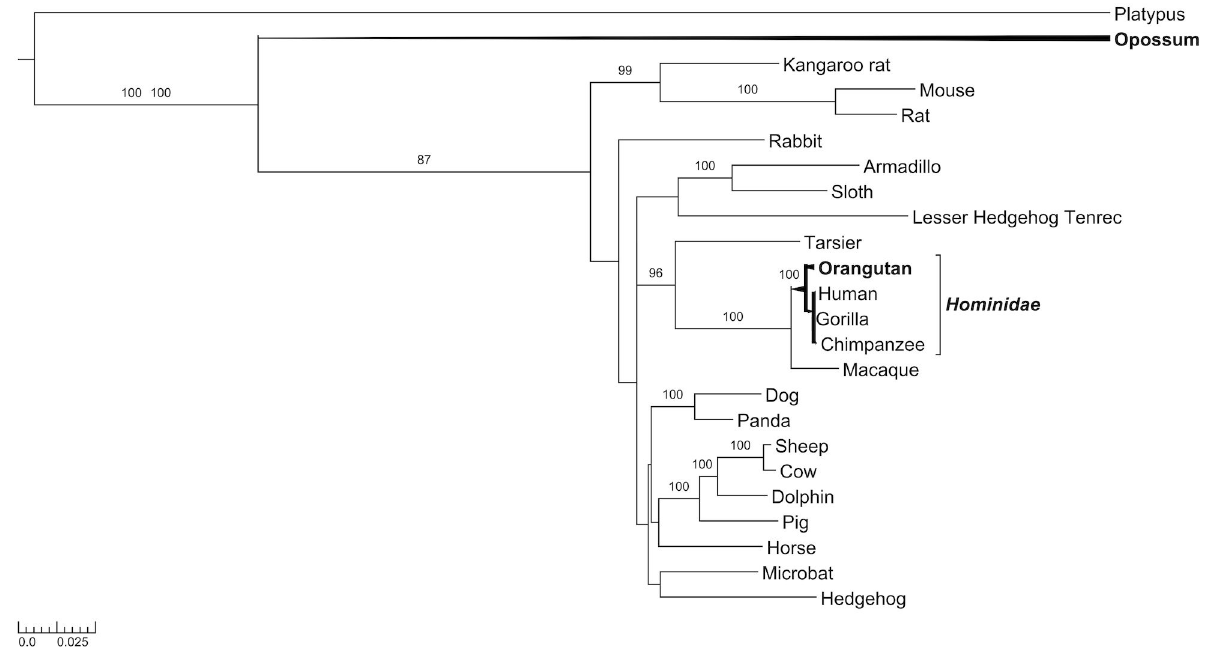
Figure 2. BMP15 positive selection pressure among mammals. Phylogenetic tree of BMP15 from 24 mammals species reconstructed using TreeBeST and rooted by minimizing with the number of duplications and losses. Bootstrap values are given when nodes are strongly supported (>80%). Branches or species that have a significant LRT for positive selection calculation are indicated in bold (threshold of q = 5% of false positives). The scale represents the substitution